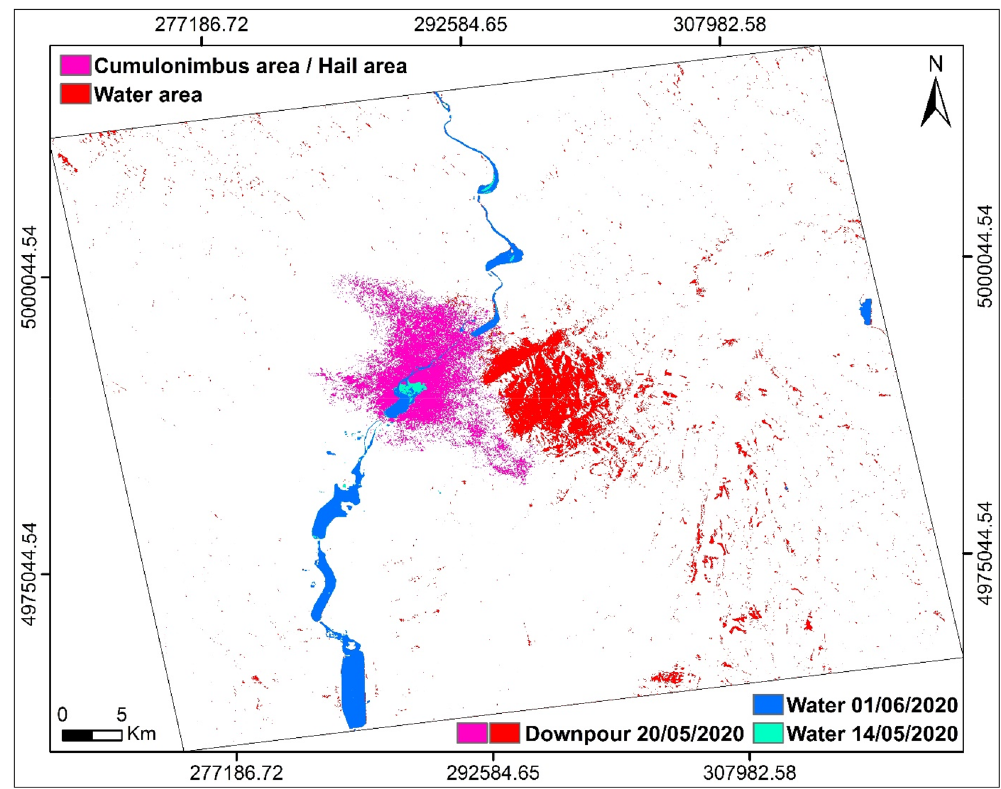
Figure 9. Downpour Impact map for 20/05/2020, produced using ArcGisPro 2.8.1.